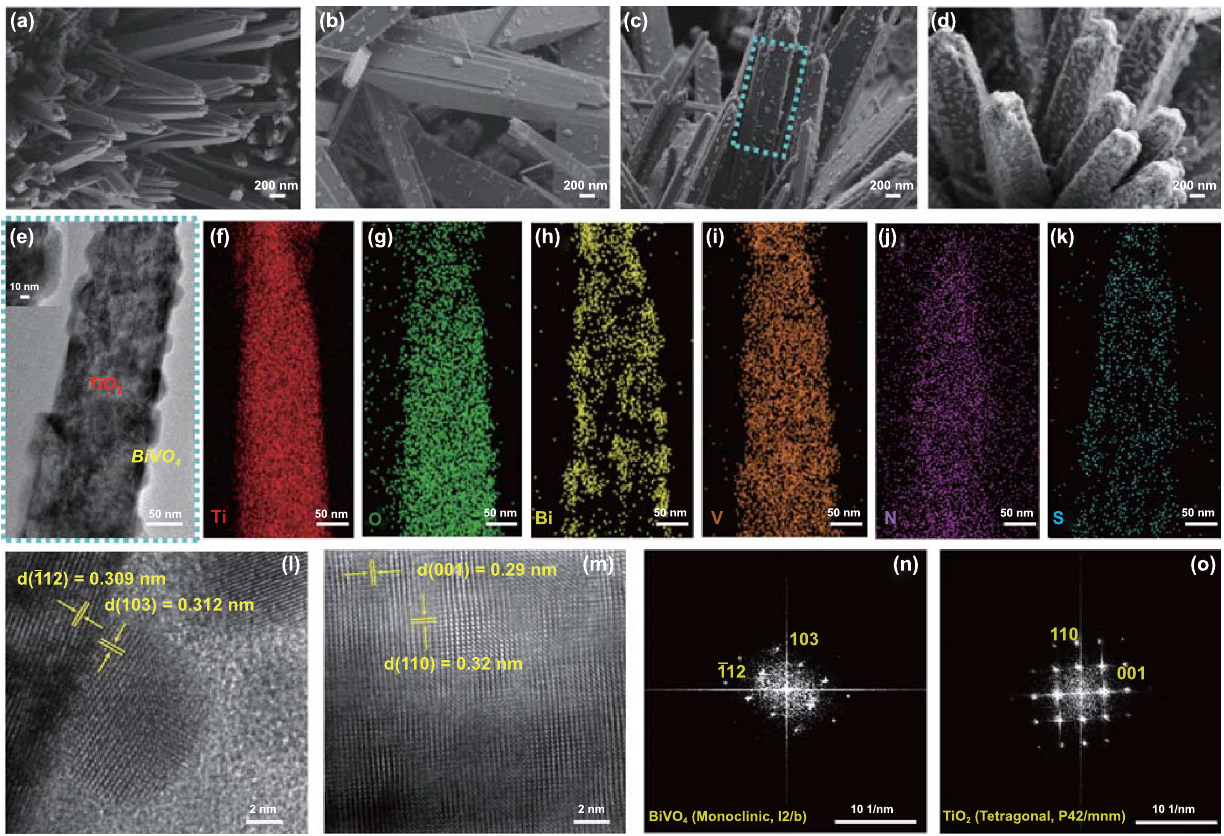
Fig. 3 SEM images of a TiO 2 NFs and BiVO 4 /TiO 2 NFs with different deposition cycles of BiVO 4 : b 6 cycles, c 18 cycles, and d 36 cycles. e TEM image of BiVO 4 /TiO 2 NFs deposited by 18 cycles. Inset shows HR‑TEM image of BiVO 4 /TiO 2 NFs. EDS mapping images of f Ti, g O, h Bi, i V, j N, and k S. l Crystalline planes of (− 112) and (103) of BiVO 4 , m Crystalline planes of (001) and (110) of TiO 2 NFs. FFT patterns of n BiVO 4 and o TiO 2